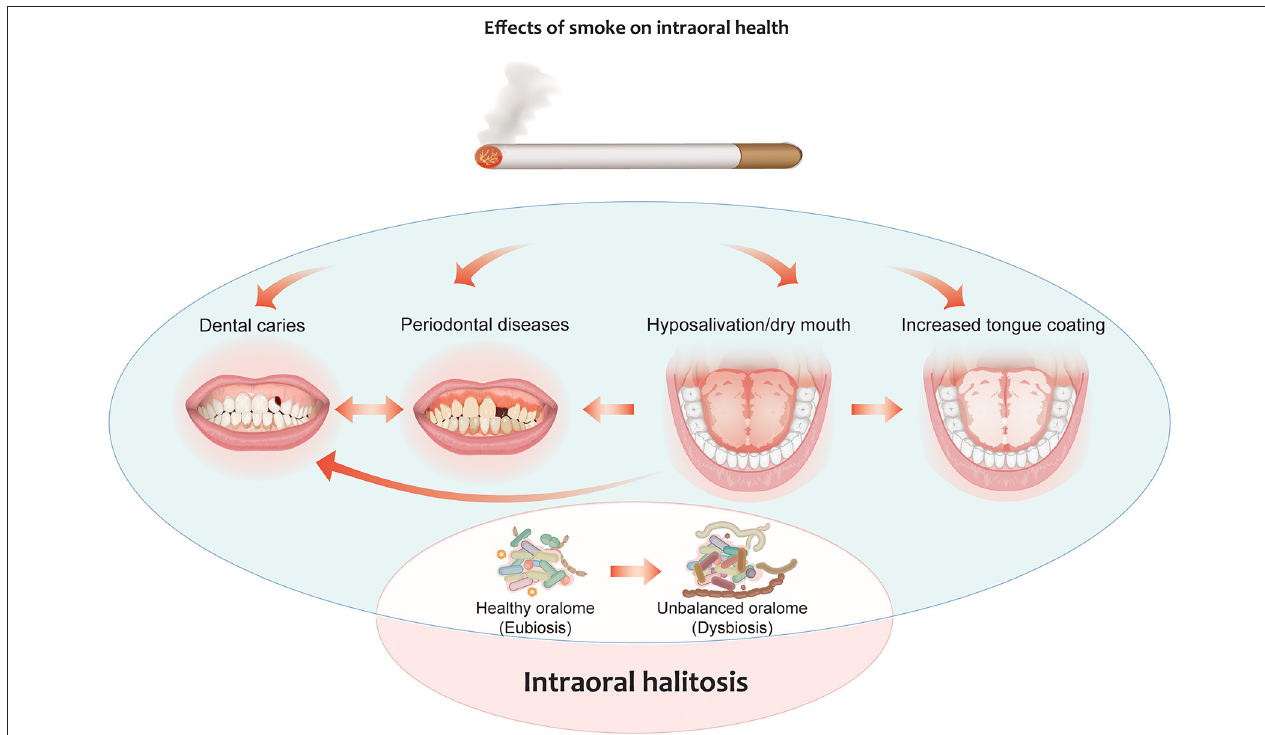
FIGURE 2 | Effects of cigarette smoking on intraoral halitosis. Cigarette smoke can contribute to halitosis by causing hyposalivation, thereby facilitating the formation of deposits on the tongue. It can also contribute to the onset of periodontal diseases and the formation of dental caries. All these effects can decrease the commensal population in the oral cavity, facilitating the acquisition and colonization of periodontal pathogens. This leads to oral dysbiosis, which can, in turn, lead to intraoral